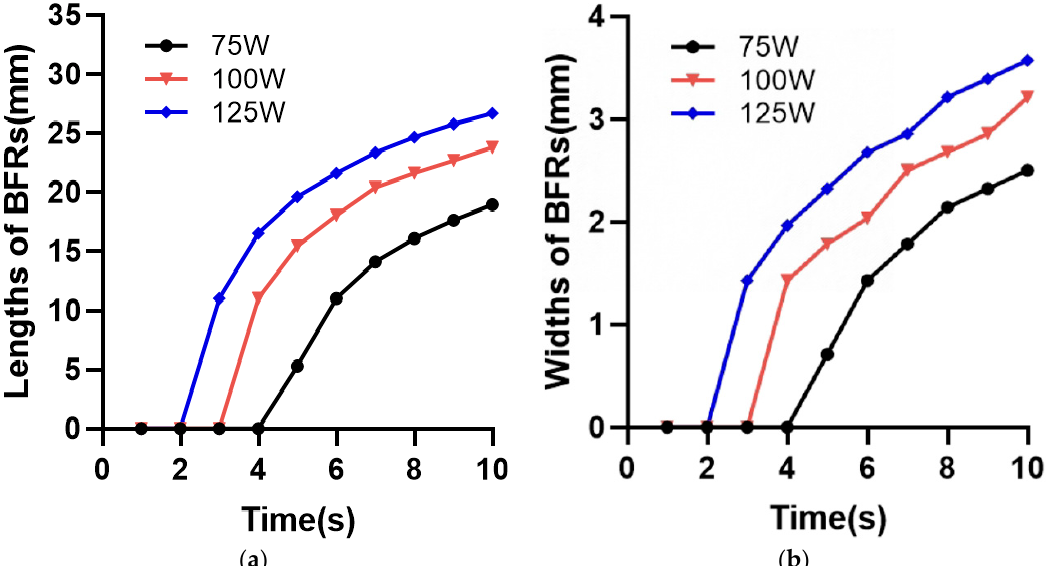
Figure 13. ( a ) Lengths and ( b ) widths of the BFRs during ultrasonication with different power in bovine liver.